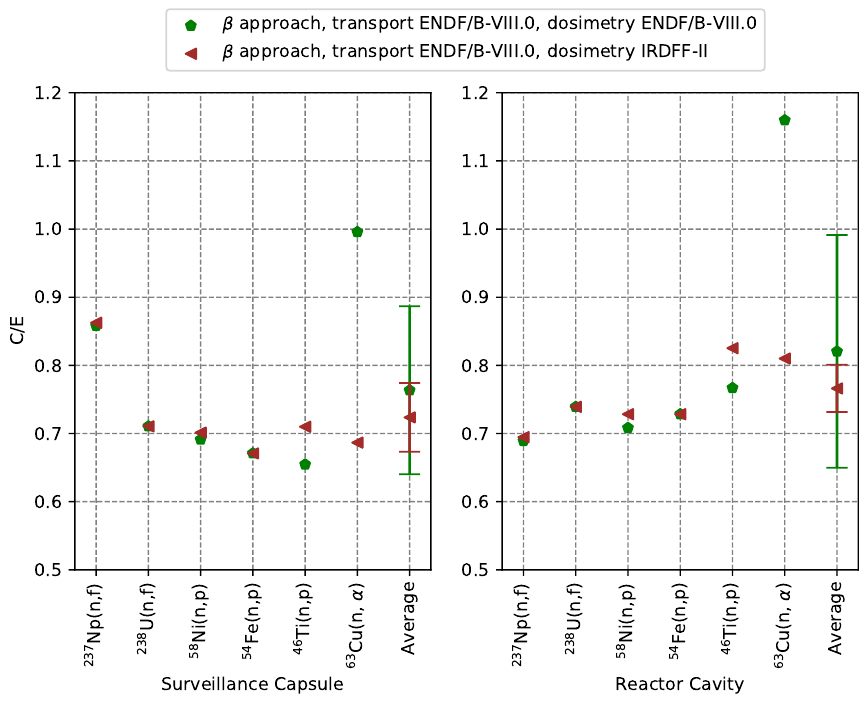
Figure 10. C/E ratios obtained with the β approach using the ENDF/B-VIII.0 library for transport and the ENDF/B-VIII.0 or IRDFF-II library for dosimetry. The 237 Np(n,f) specific activity is not taken into account in the calculation of the average C/E value in the